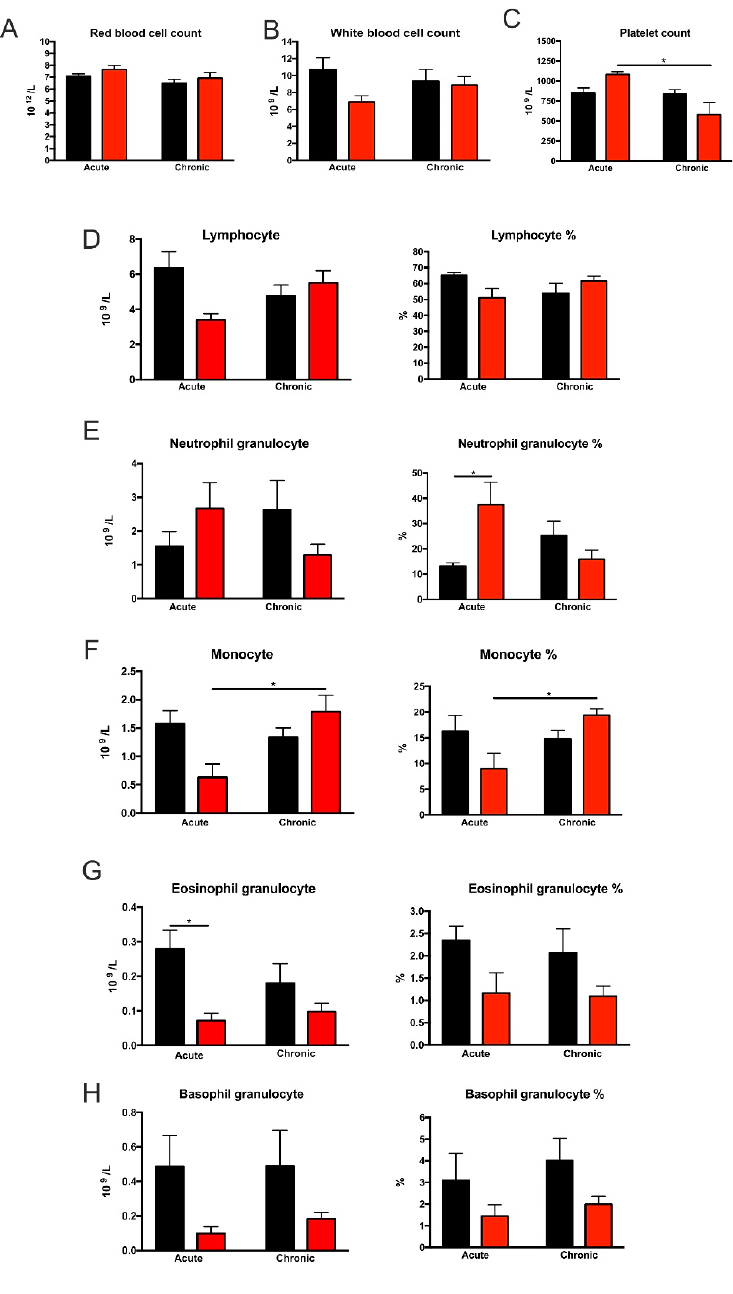
Figure 4. Inflammatory arthritis altered specific parameters of the complete blood cell count. Erythrocyte ( A ) and leukocyte cell numbers ( B ) were not influenced by the CFA treatment, but platelet numbers decreased in the Chronic CFA-treated animals compared to the acute phase ( C ). Lymphocyte cell numbers and percentage were not altered ( D ), but we found a significant increase in the neutrophil granulocyte ratio of the Acute CFA-treated animals ( E ). We also found a significant difference in monocyte cell numbers and the percentage between the Acute and Chronic CFA-treated animals ( F ). The total number of eosinophil granulocytes was reduced in the acute CFA-treated animals ( G ). Two-way ANOVA revealed a significant main effect of CFA-treatment on eosinophil and basophil granulocyte numbers and ratios ( G , H ). Statistical analysis: two-way ANOVA (time × CFA treatment) followed by Tukey’s multiple comparisons post hoc test. * p < 0.05. Abbreviations: complete Freund’s adjuvant (CFA); percentage (%).